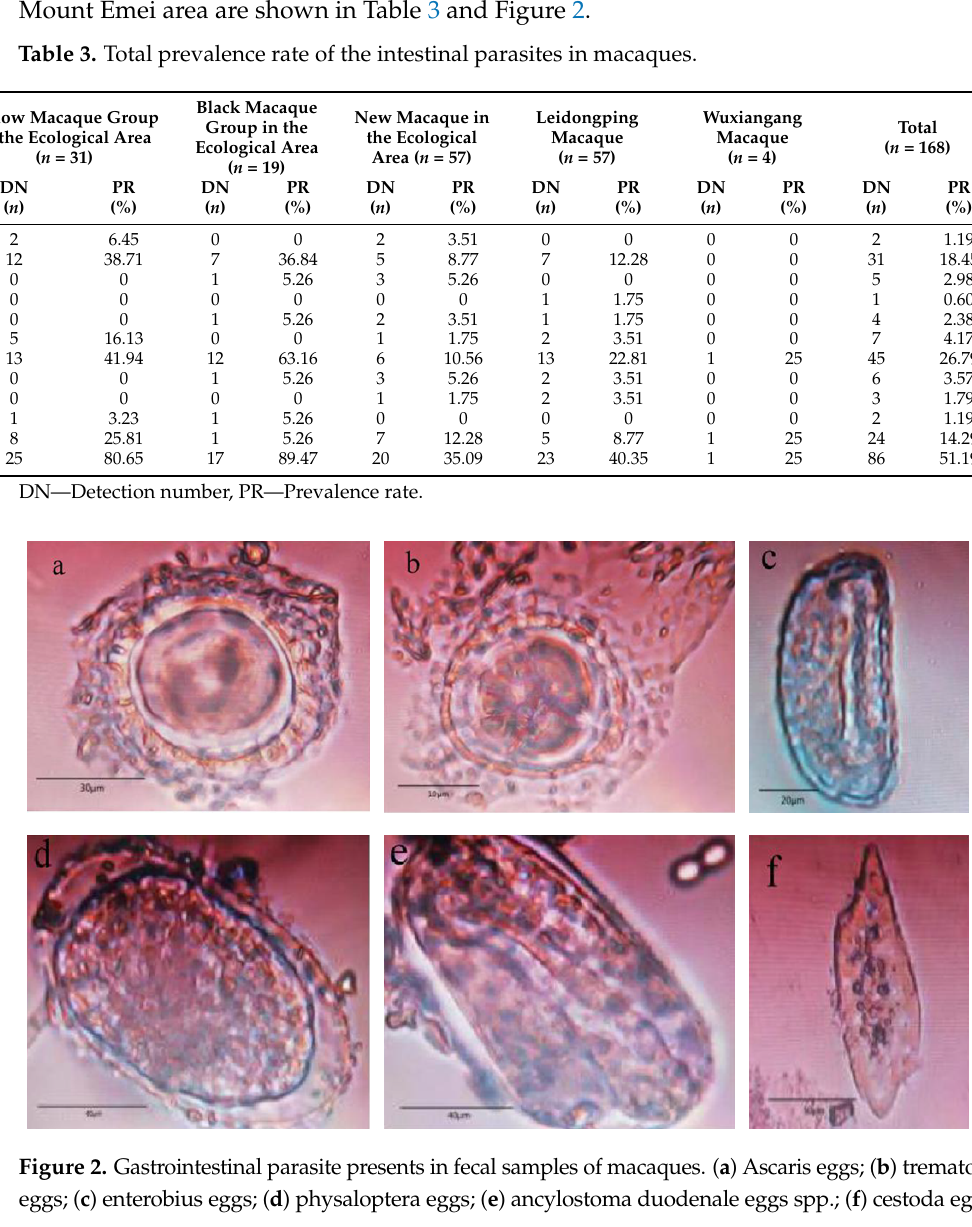
der of prevalence as follows; black macaque 89.47% (17/19), yellow macaque 80.64% (25/31), leidongping macaque 40.35% (23/57), new macaque 35.09% (20/57) and wu ‐ xiangang 25% (1/4). It was also observed that the black macaque group recorded the high ‐ est rate of intestinal parasite prevalence as compared to the other macaque groups ( p < 0.05). In addition, we observed no significant difference in the rate of intestinal parasite prevalence among the yellow, leidongping and wuxiangang macaque groups ( p > 0.05, p > 0.01). We also observed that the total intestinal prevalence rate significantly correlated with the contact frequency of tourists (r = 0.8479, p = 0.0348) (Figure 3). 3.4. The Prevalence of the Intestinal Parasite during Different Seasons Table 4 shows the results of the rate of prevalence of intestinal parasites in macaques in different seasons. The rate of prevalence was arranged in descending order of preva ‐ lence as follows: summer 86.21% (50/58), spring 61.29% (19/31), autumn 56.52% (13/23) and winter 7.14% (4/56). We observed that the summer season had the highest rate of prevalence of intestinal parasites compared with the other seasons ( p < 0.05). Moreover, we also observed no significant correlation between the contact frequency and the preva ‐ lence rate of macaques during different seasons (r = 0.8349, p = 0.0825) (Figure 4).